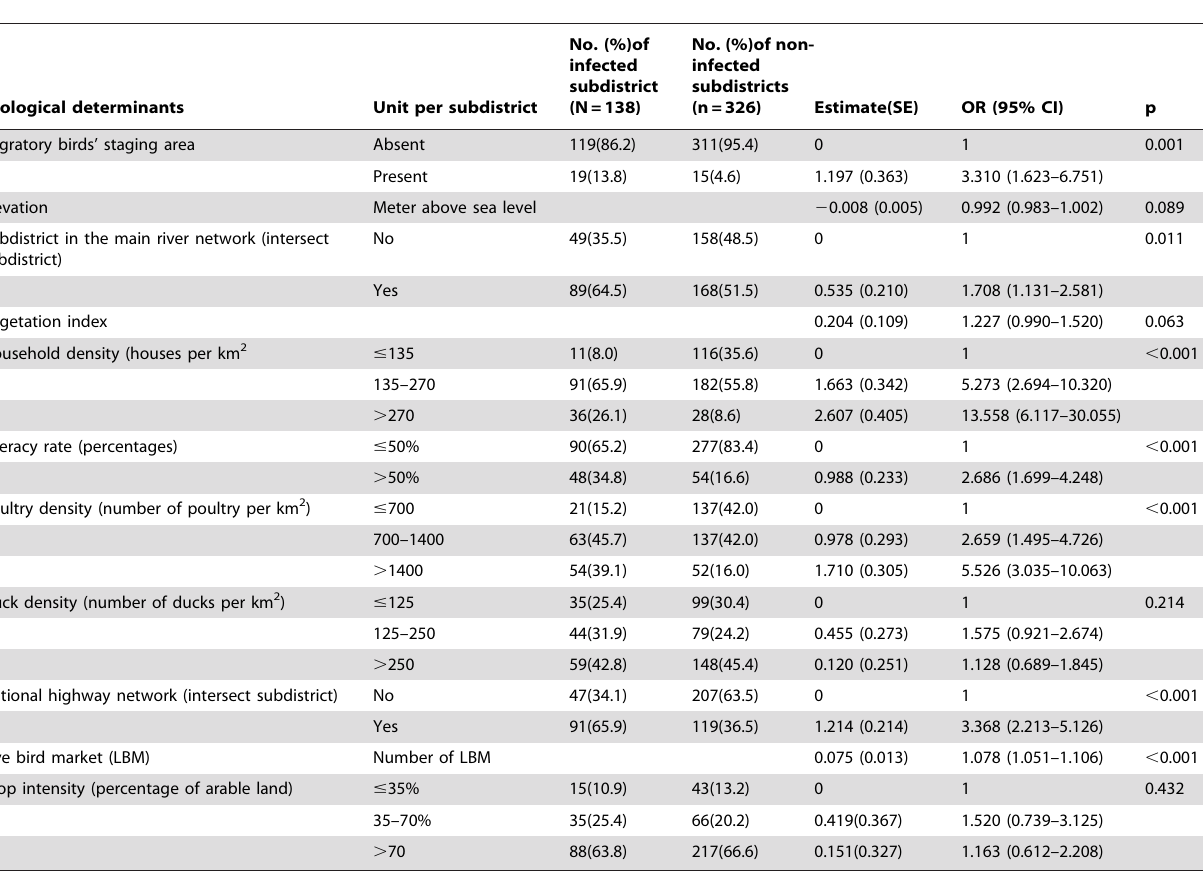
Table 2. Univariable logistic analysis of potential ecological determinants of HPAI-H5N1 virus outbreaks at subdistrict level in Bangladesh.